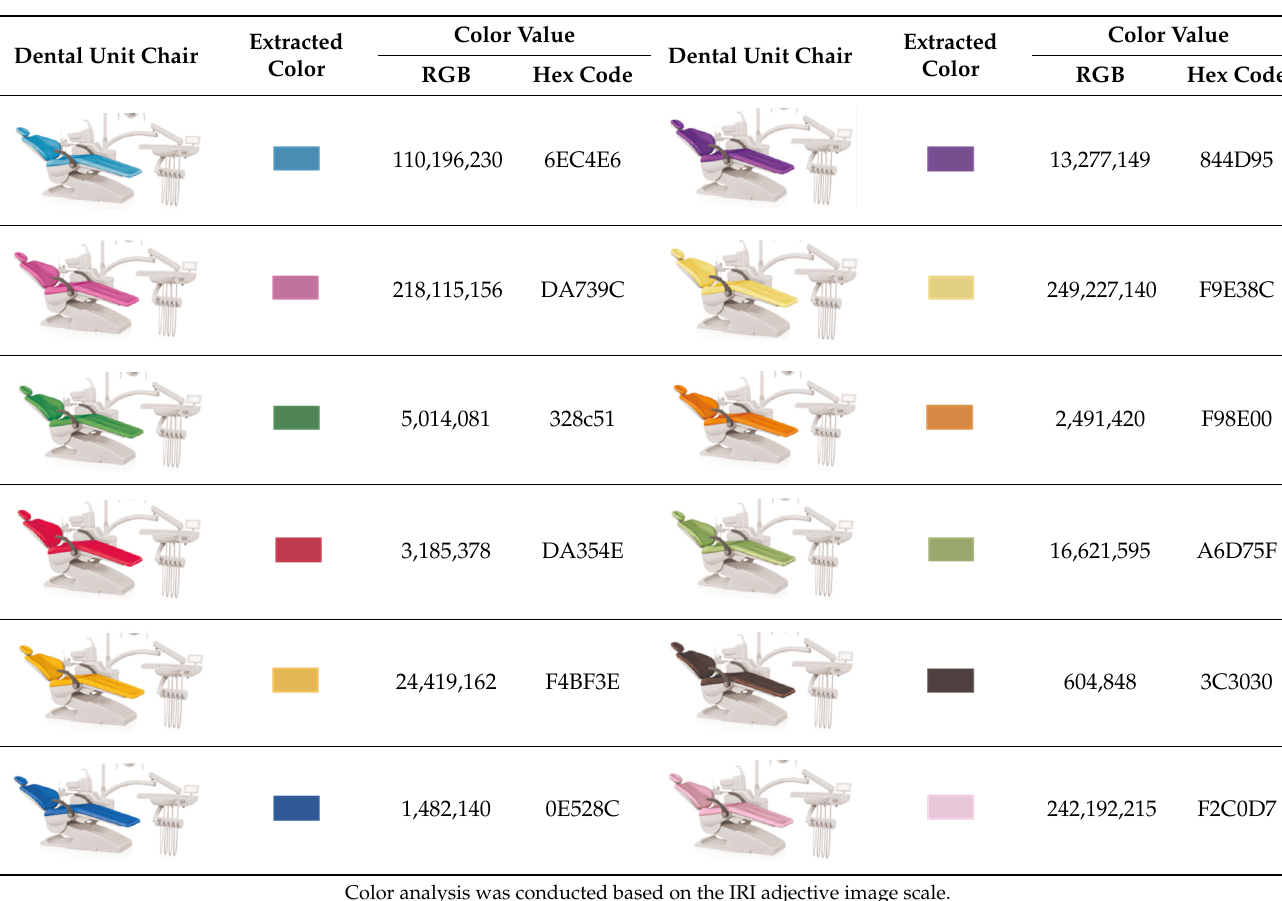
Table 4. Data for 12 extracted colors frequently used for a dental unit chair.